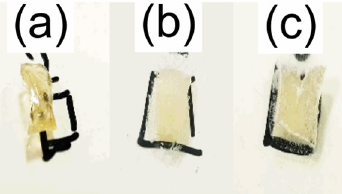
Figure 8. Photographs of the impregnated HPG-OA1 samples after the drying step. Samples impregnated in IBU solutions of ( a ) 0.05, ( b ) 0.5 and ( c ) 0.75 g mL − 1 .